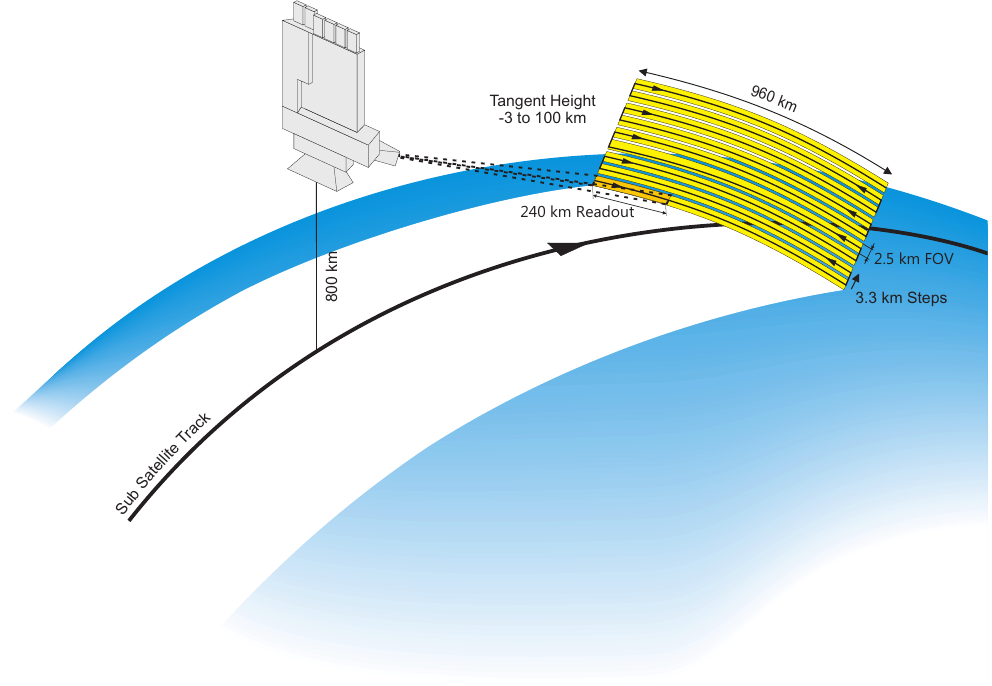
Fig. 1. Typical limb observation sequence as performed by the SCIAMACHY